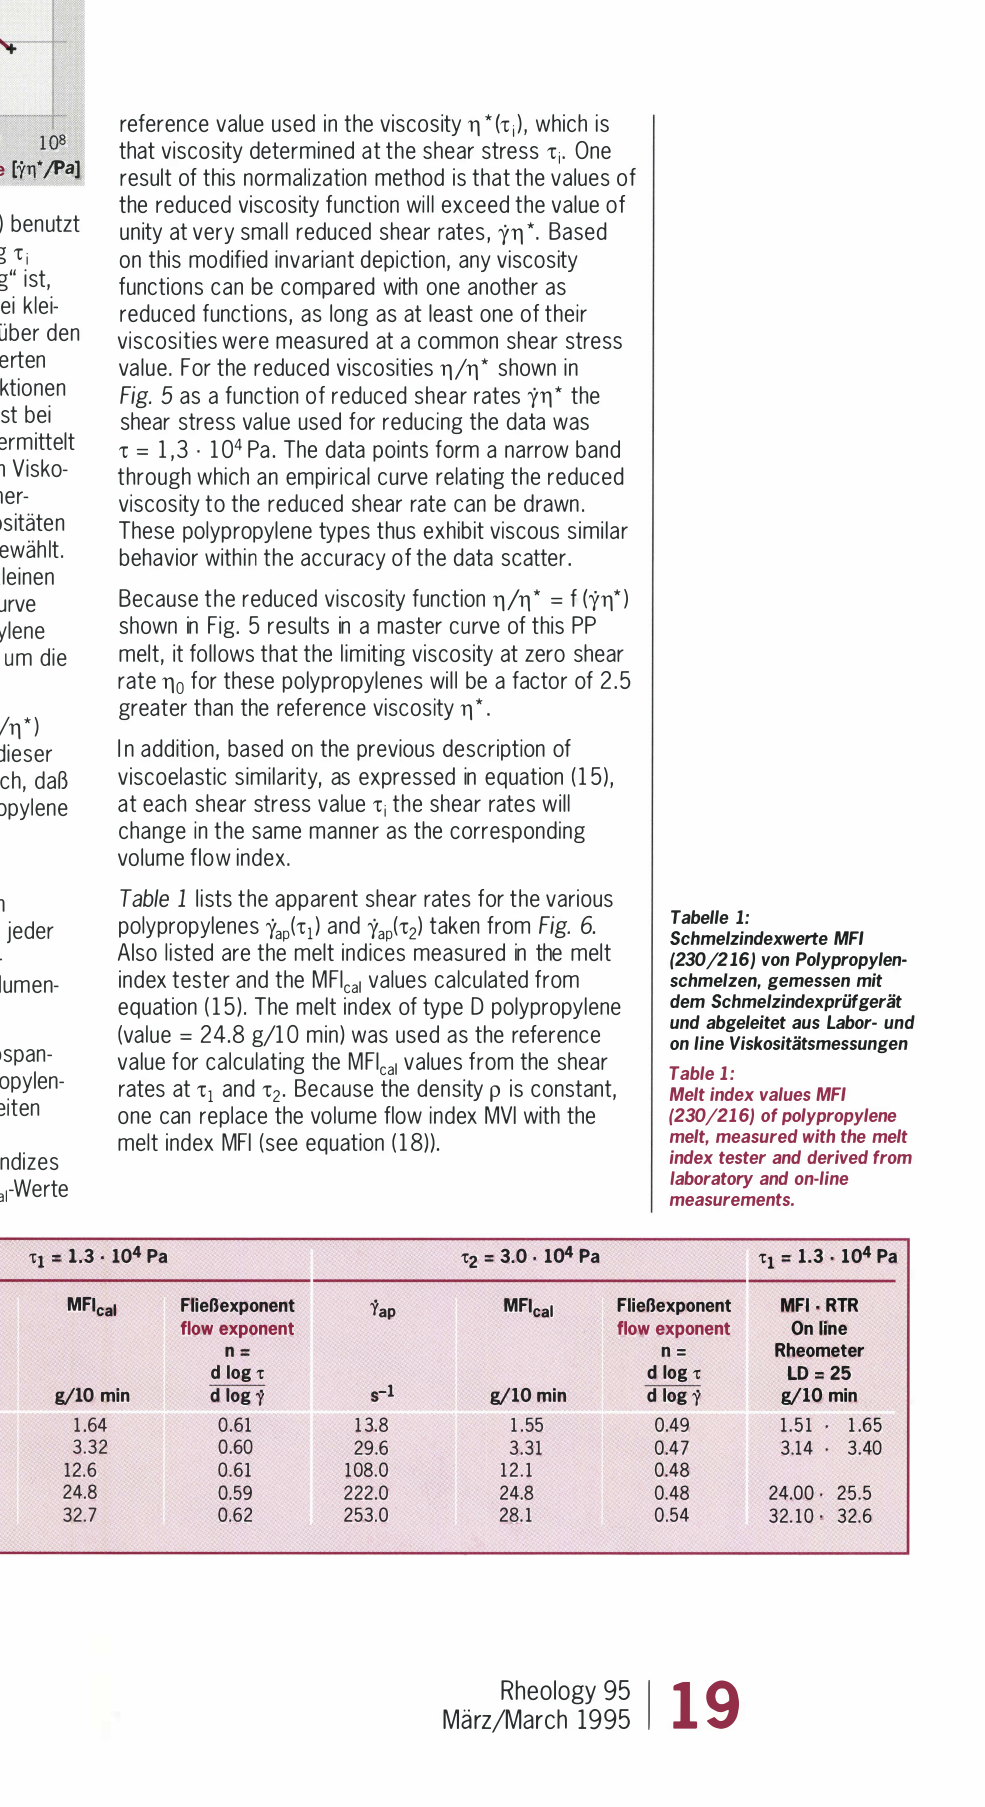
Fig. 5: Reduced viscosity functions of different polypropylene melts. TJ* is the reference viscosity at a shear stress -r = 1.30. 1CJ4 Pa